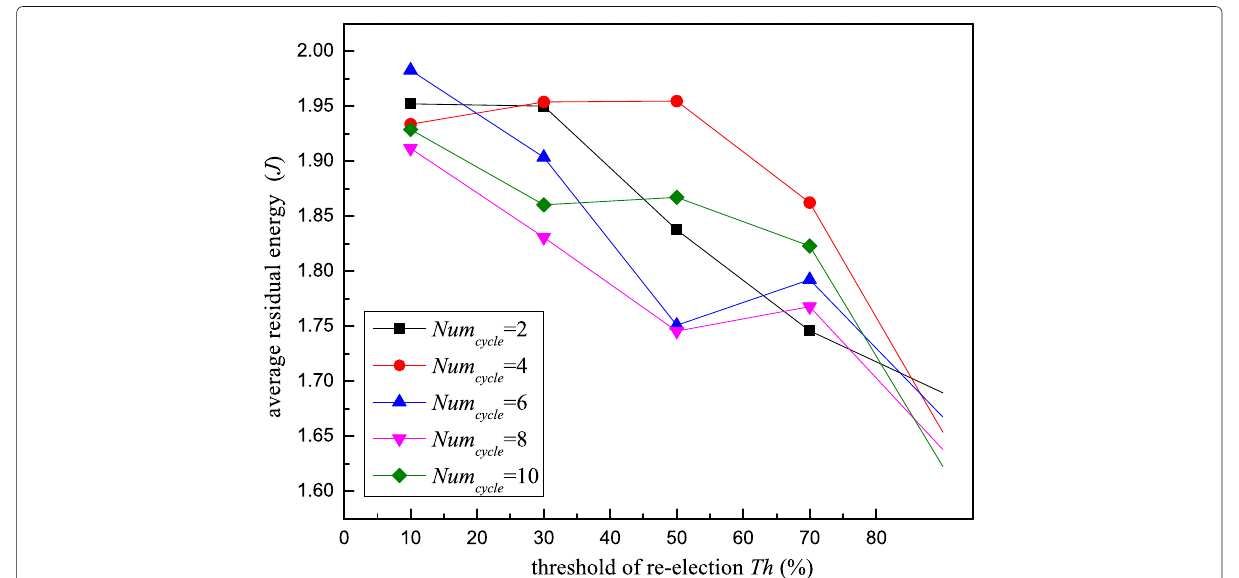
Fig. 10 The average residual energy under different Th and Num cycle . When Num c ycle was 8, the energy utilization rate was the highest